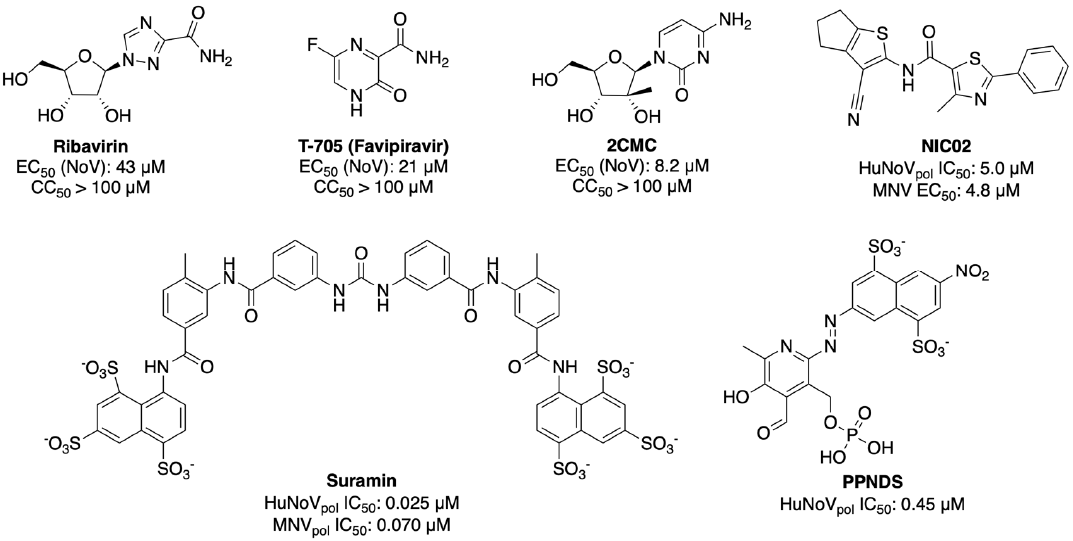
Figure 1. Chemical structures of previously reported inhibitors of norovirus RdRp [16].